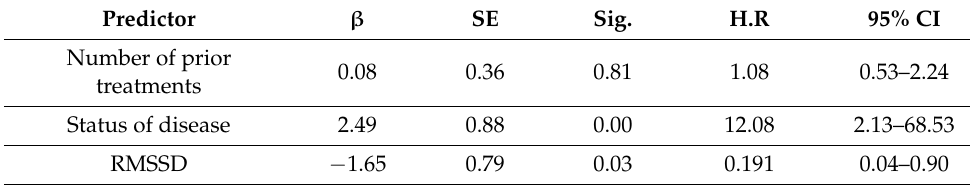
Table 4. Multivariate Cox regression between all significant bivariate predictors and PFS.